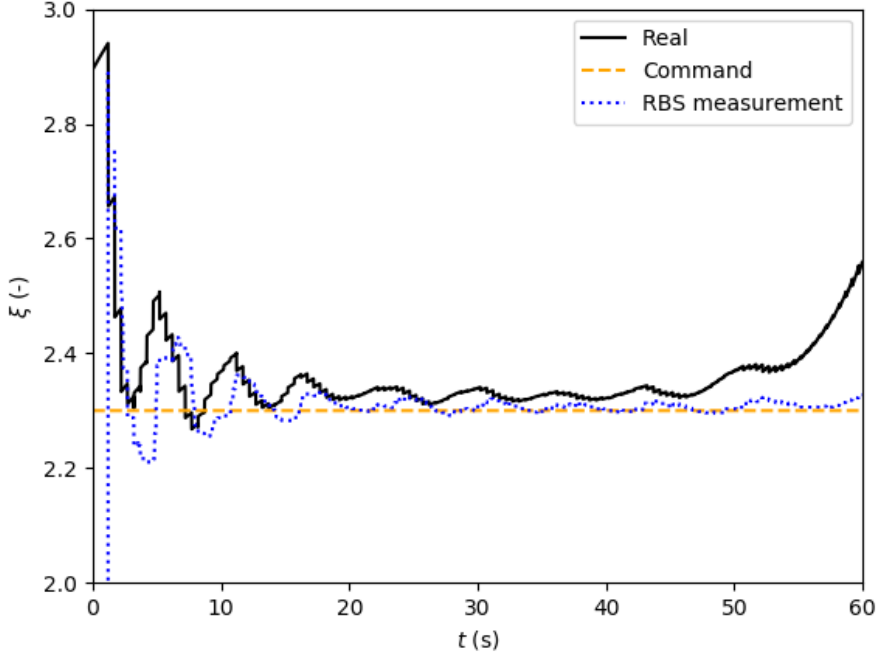
Figure A10. Mixture ratio profile, feedback with downgraded regulation law, case